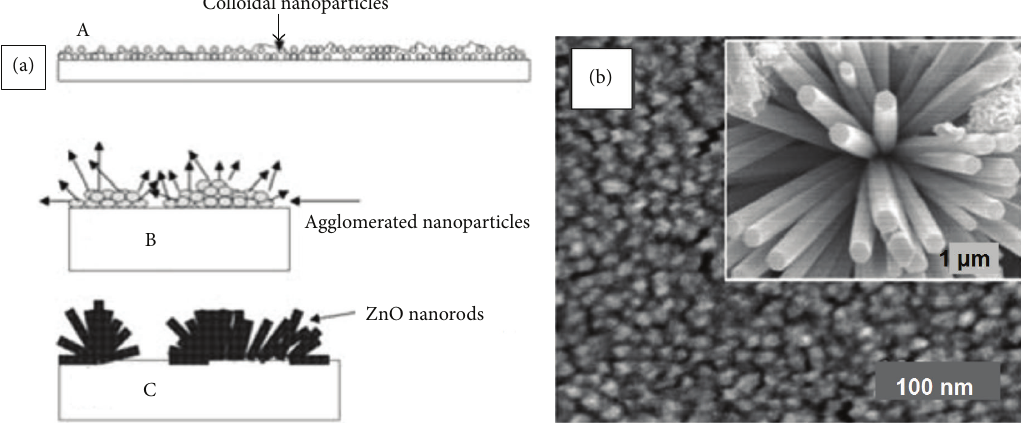
Figure 9: (a) Schematic diagram showing the possible agglomeration of ZnO nanoparticles upon evaporation of the solvent (A), thin layer of colloidal nanoparticles (B), and agglomerated clumps of ZnO nanoparticles with various orientations of the 𝑐 -axes of the nanocrystallites (C). (b) Scanning electron microscope (SEM) image of ZnO particle seed layer using colloidal ZnO nanoparticles. Inset: ZnO nanorods grown using a 10mM growth solution for 15h (reproduced with the permission from [60]).